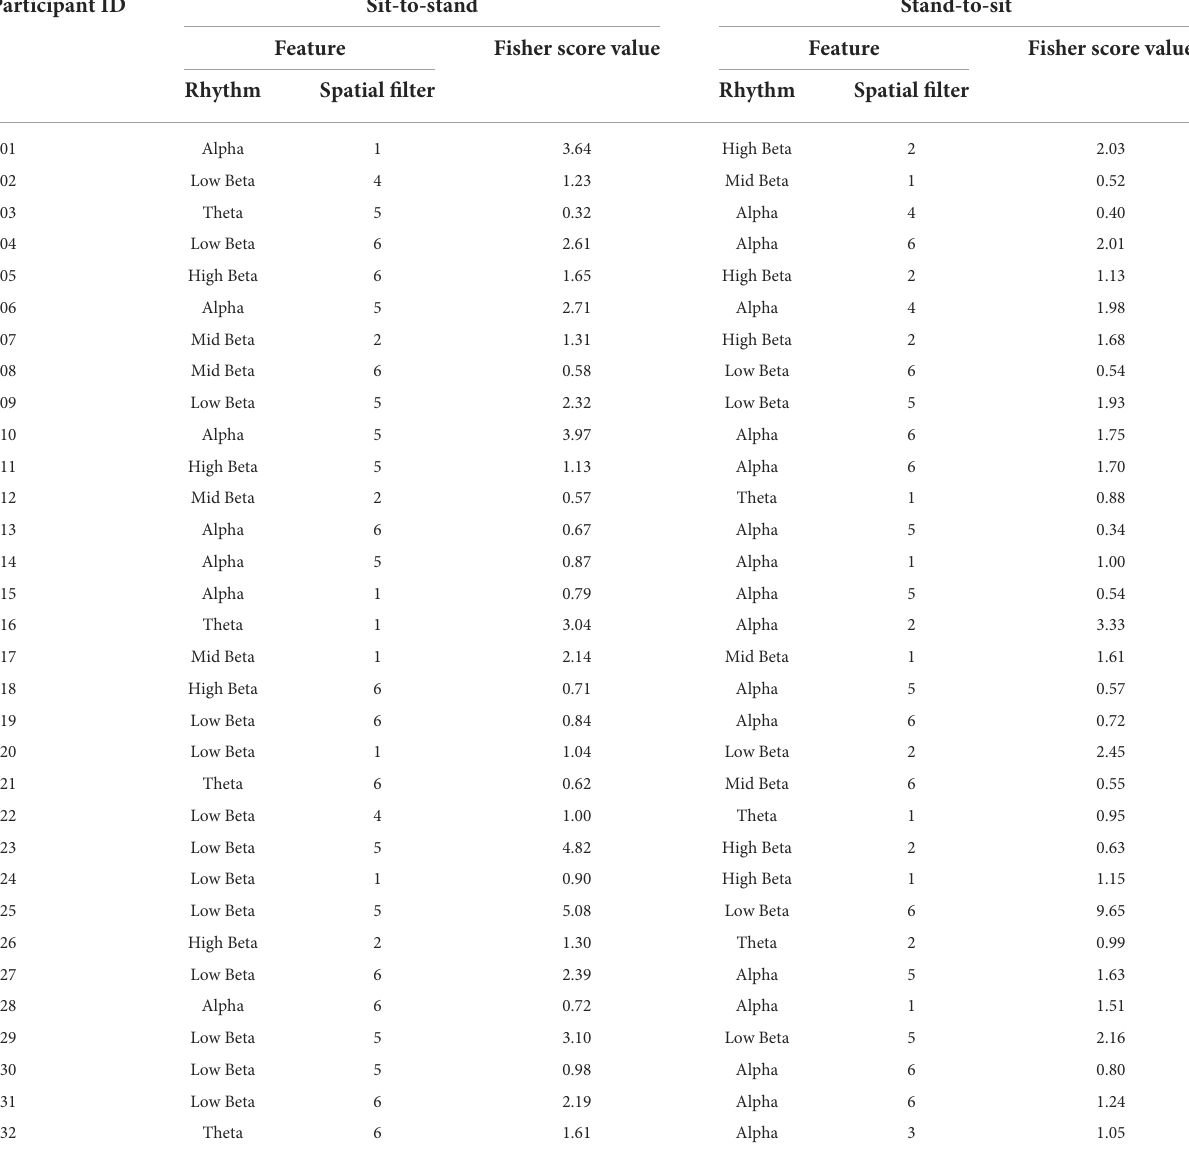
TABLE 1 Comparison of the highest-ranking